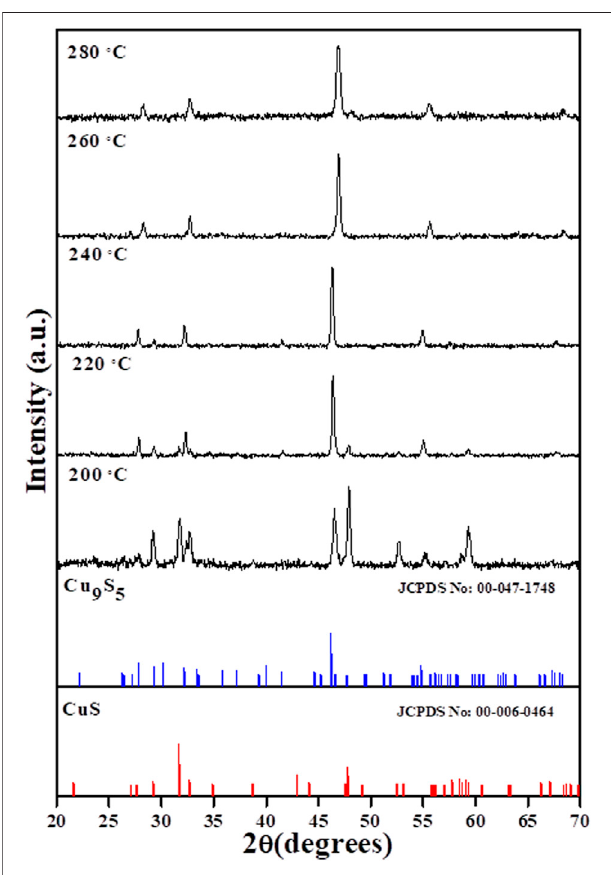
FIGURE1| XRDpattern ofthecopper sul fi de nanoparticles obtained by the thermolysis of Cu(II) bis( N -methyl- N -phenyl dithiocarbamate) in the temperature range of 200 – 280 °